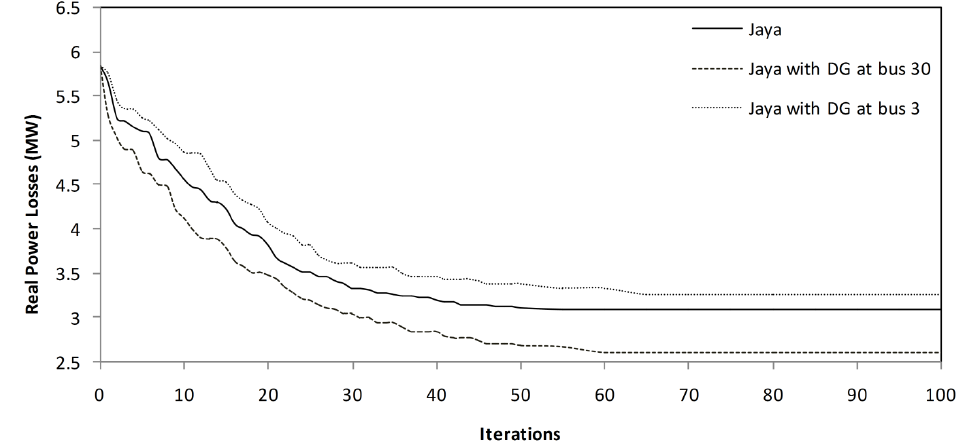
Figure 5. Convergence of Jaya method for case 2.